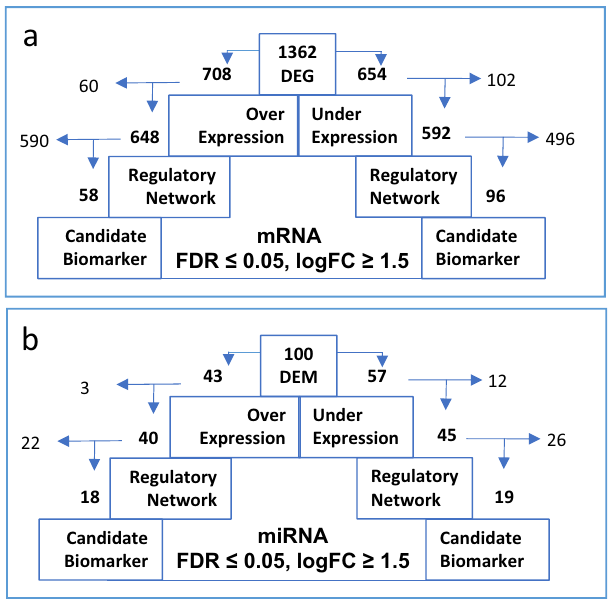
Figure 1. Analysis flow of ( a ) DEGs and ( b ) DEMs in MM showing number of genes/ miRNAs with upregulated expression on left hand side and downregulated expression on the right side. ( a ) Out of 1,362 DEGs, 708 were over-expressed, out of which 648 were found to be involved in regulatory network with miRNA and 58 DEGs ultimately showed up as possible candidate biomarker in MM. Similarly, 96 of downregulated DEGs were found to have the possible potential to be investigated further as candidate biomarkers. ( b ) Expression of 45 and 40 out of 100 DEMs was downregulated or upregulated respectively, and ultimately 19 and 18 subsets of these turned up to be possible candidate biomarkers for